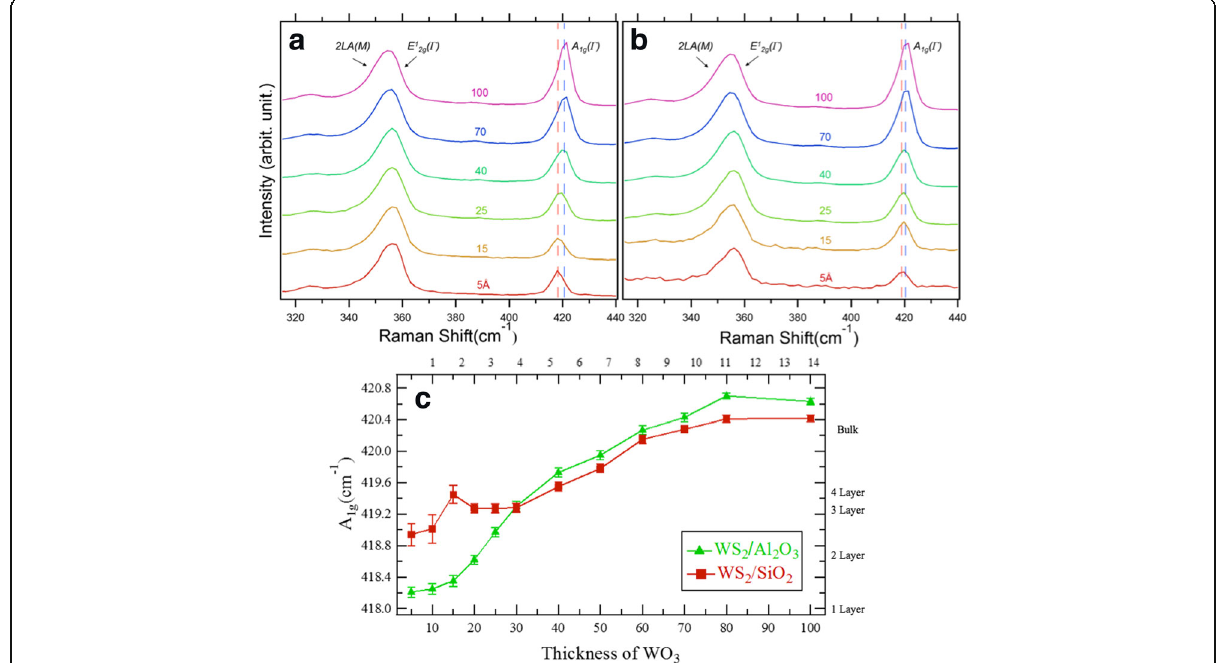
Fig. 3 a Raman spectra from 0.5-nm- to 10-nm-thick WS 2 grown on Al 2 O 3 and b SiO 2 substrate as a function of WO 3 thickness ( d WO3 ) (514.5 nm laser excitation, 300 K). The peaks at ~355 and ~420 cm − 1 correspond to overlap of 2LA(M) and E 1 2g ( Γ ) peaks and A 1g ( Γ ) peak, respectively. Blue and red dashed lines indicate the A 1g ( Γ ) peak position of the thick sample ( d WO3 = 10 nm) and thin sample ( d WO3 = 0.5 nm), respectively. Intensities are normalized with the A 1g peaks. c Thickness dependence of the A 1g ( Γ ) peak